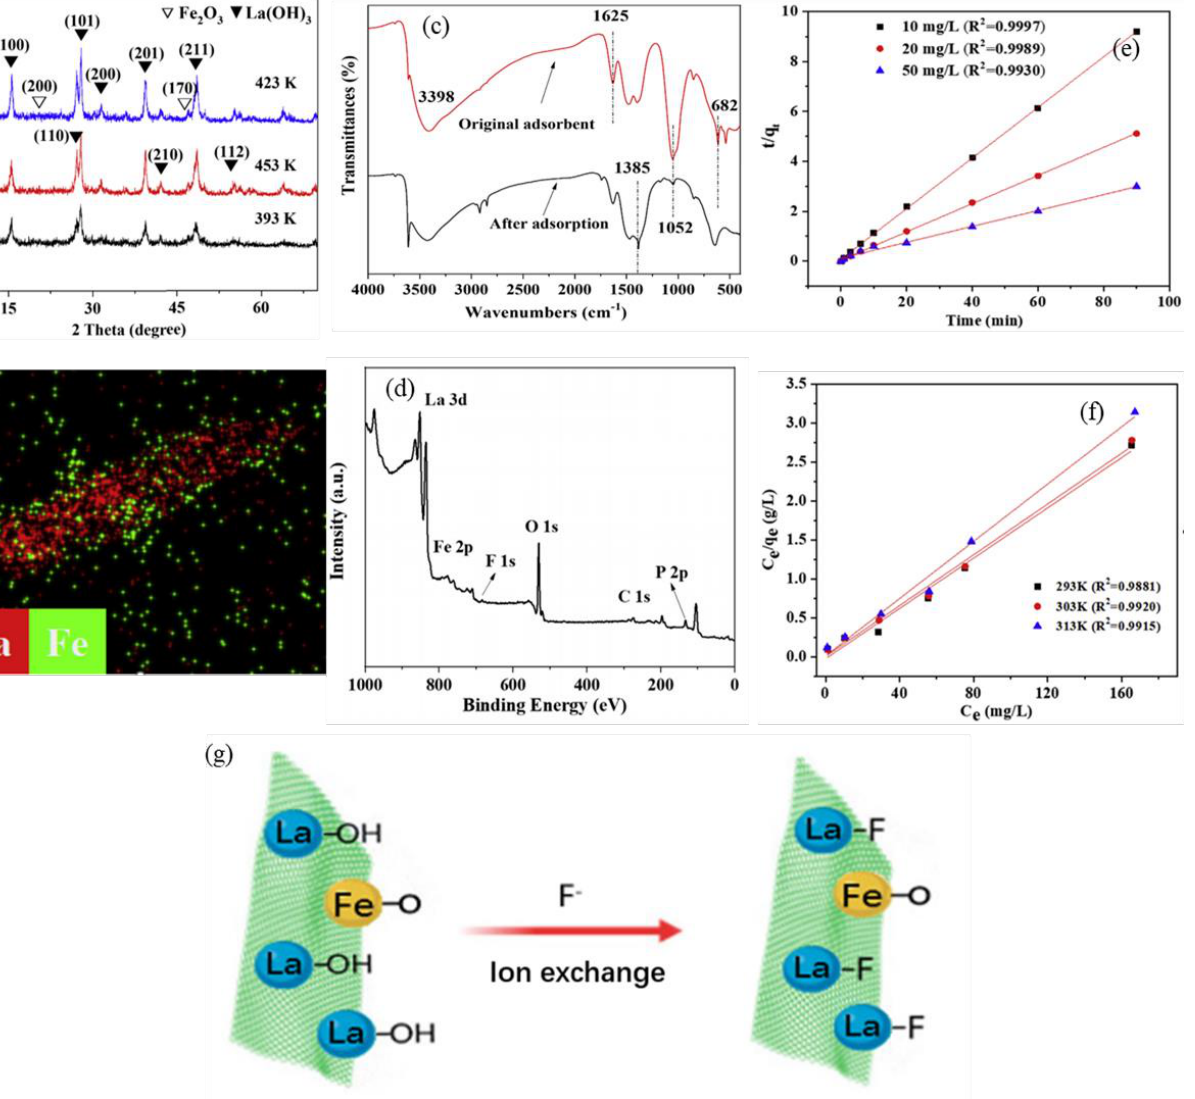
Figure 2. Adsorption of fluoride by Fe−La composites. ( a ) XRD result of Fe−La composites; ( b )TEM mapping result of Fe−La composites; ( c ) FI−IR result of Fe−La composites; ( d ) XPS result of Fe−La composites; ( e ) adsorption kinetics of fluorine by Fe−La composites; ( f ) adsorption isotherm of fluorine by Fe−La composites; and ( g ) adsorption mechanism of fluoride by Fe−La composites [60].